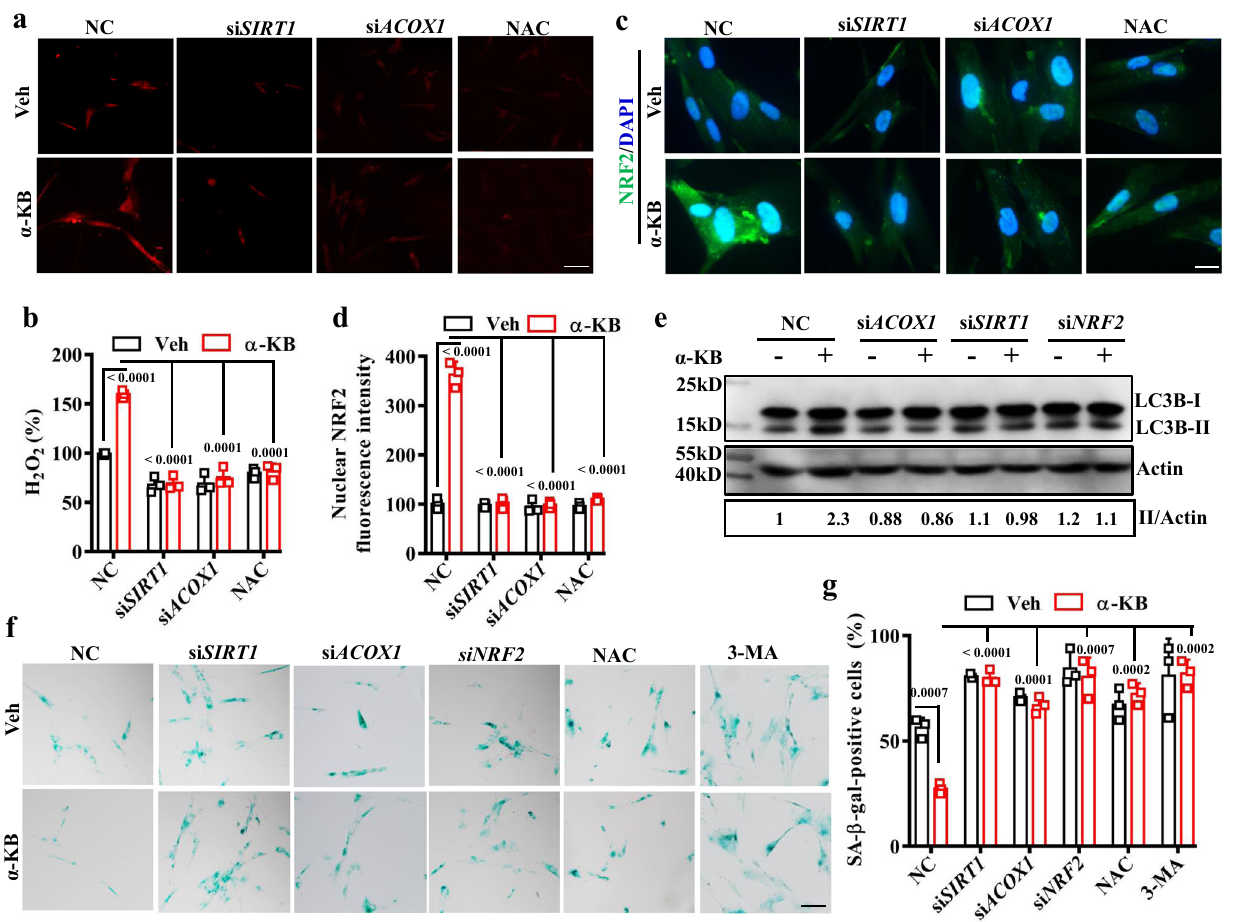
Fig. 6 | Alpha-KB delays senescence in mammalian cells. a Representative images of H 2 O 2 formation detected by fl uorescence dye DCHP in IMR90 cells. Scale bars: 15 μ m. b Quanti fi cation of Fluorescence intensity. The H 2 O 2 levels were increased in cells treated with α -ketobutyrate ( α -KB, 500 μ M) for 12h, which was inhibited by RNAi knockdown of SIRT1 or ACOX1 , or pre-treatment with N -acetylcysteine (NAC, 5mM). Data were presented as mean values ±SEM of three independent experiments. P values were calculated using a one-way ANOVAfollowedbyaStudent – Newman – Keulstest. c Representative imagesof immuno fl uorescence staining with anti-NRF2 antibodies. Scale bars: 5 μ m. d Quanti fi cation of fl uorescence intensity of NRF2 in the nucleus. Supple- mentation with α -KB (500 μ M) induced nuclear accumulation of NRF2